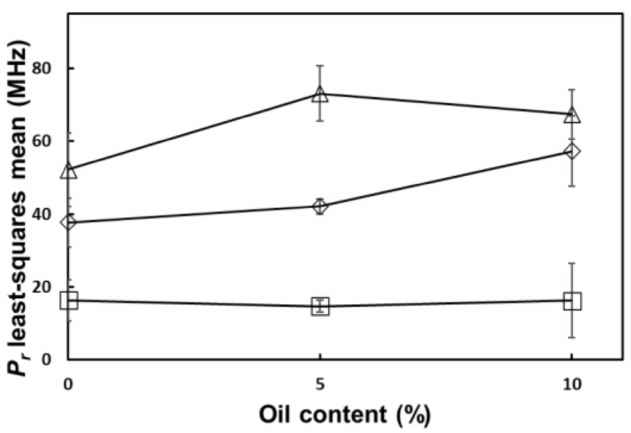
Figure 5. Salt and oil interaction effect on the reversion point of tomato homogenate ( ) 0% salt ( ) 0.5% salt ( ) 1% salt. Error bars correspond to standard